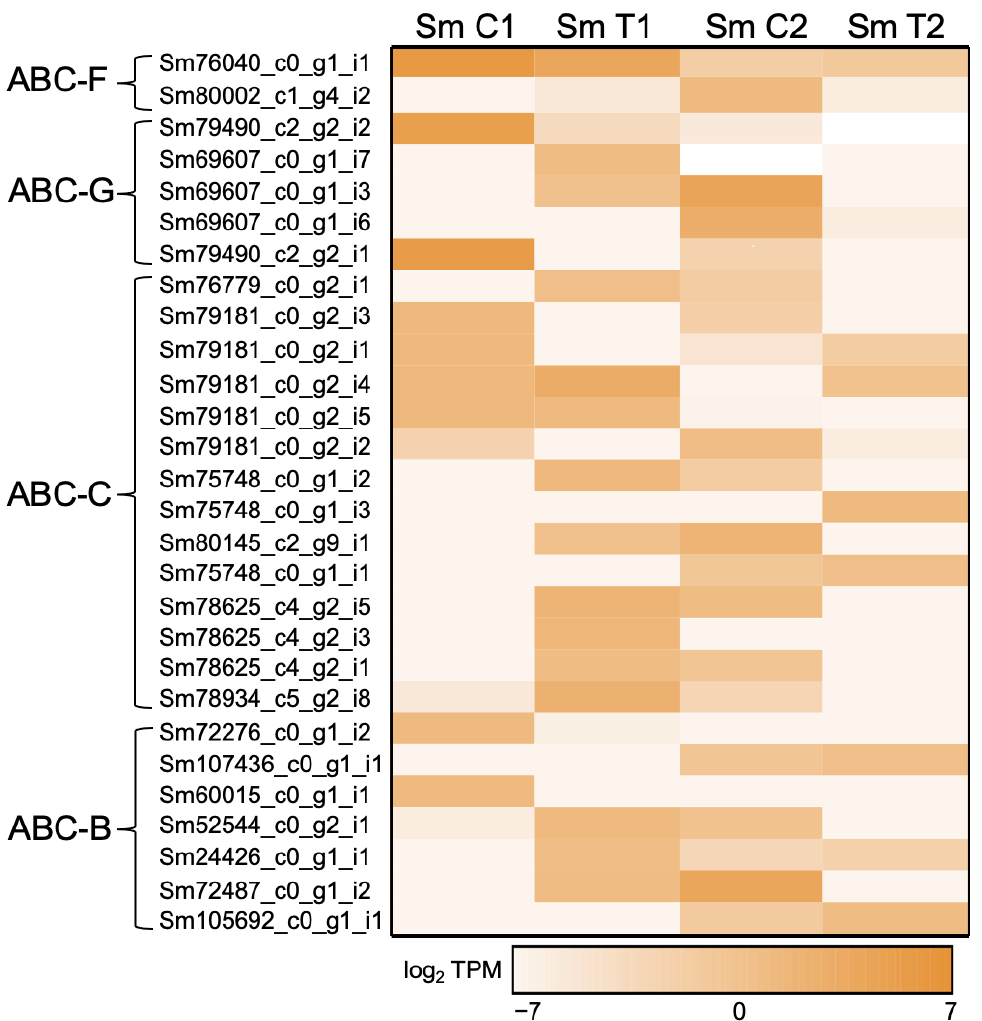
Figure 4. RNA-Seq heat map revealing relative gene expression of selected transcripts for four families of ABC transporters (ABC-B, -C, -G, and -F) in S. mycoparasitica interacting with Fusarium graminearum 3-ADON. Sm C1 and Sm C2 represent S. mycoparasitica incubated for 1.5 and 3.5 days, respectively, without interaction with the host, whereas Sm T1 and Sm T2 represent S. mycoparasitica interacting with the host for respective incubation times (1.5 and 3.5 days). The log 2 transformed transcripts per million (TPM) values were applied for comparisons of relative gene expression to depict the overexpressed genes.